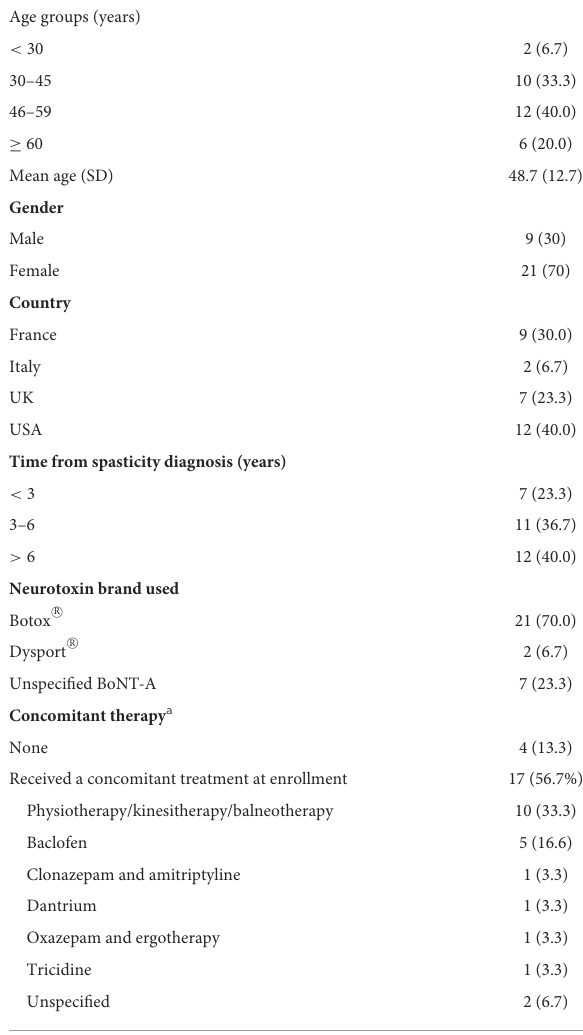
TABLE 1 Patient baseline demographics and